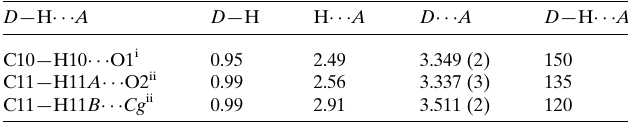
Table 2 Experimental details.